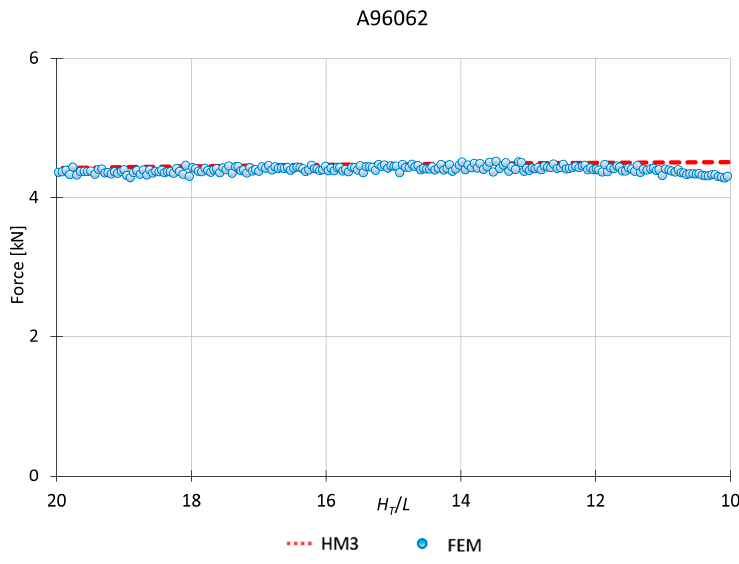
Figure 9. MUBT-FEM comparison for A96062, n = 0.10.